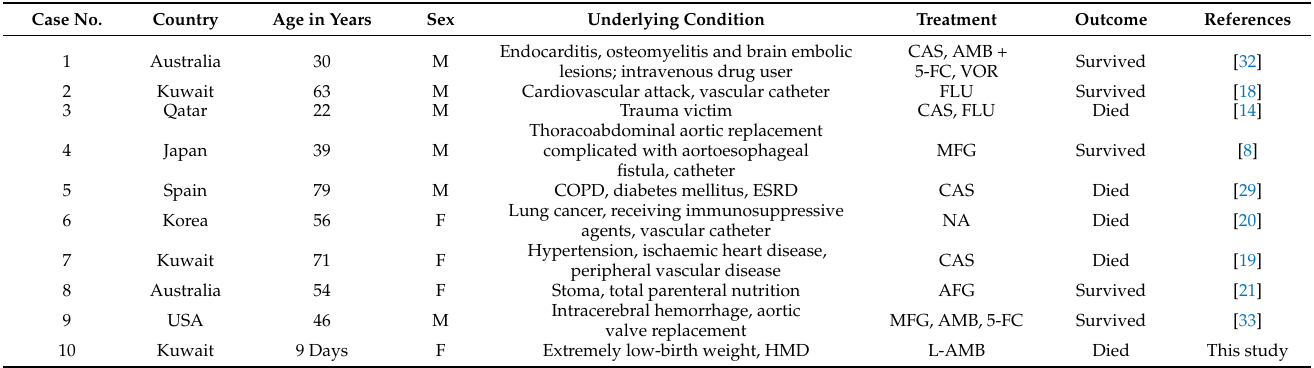
Table 2. List of reported cases of L. elongisporus fungemia